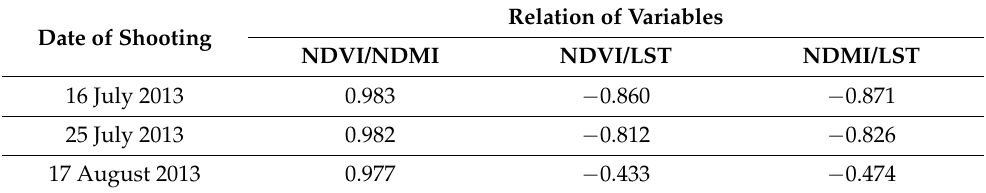
Table 4. Pearson correlation coefficients between vegetation indices and LSTs.